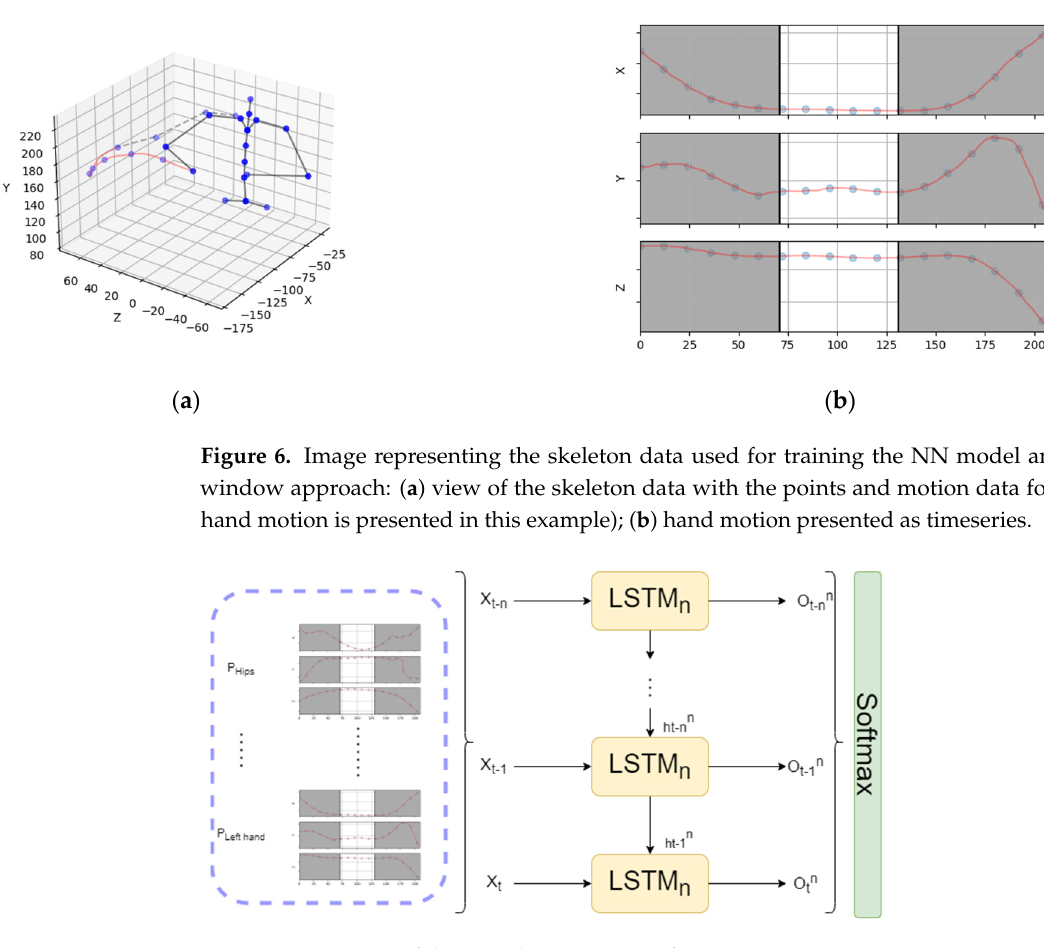
Figure 7. Overview of the complete LSTM NN for activity recognition.